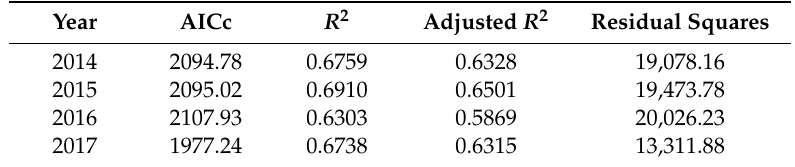
Table 1. Estimation and validation of regression results of the geographically weighted regression (GWR) model.